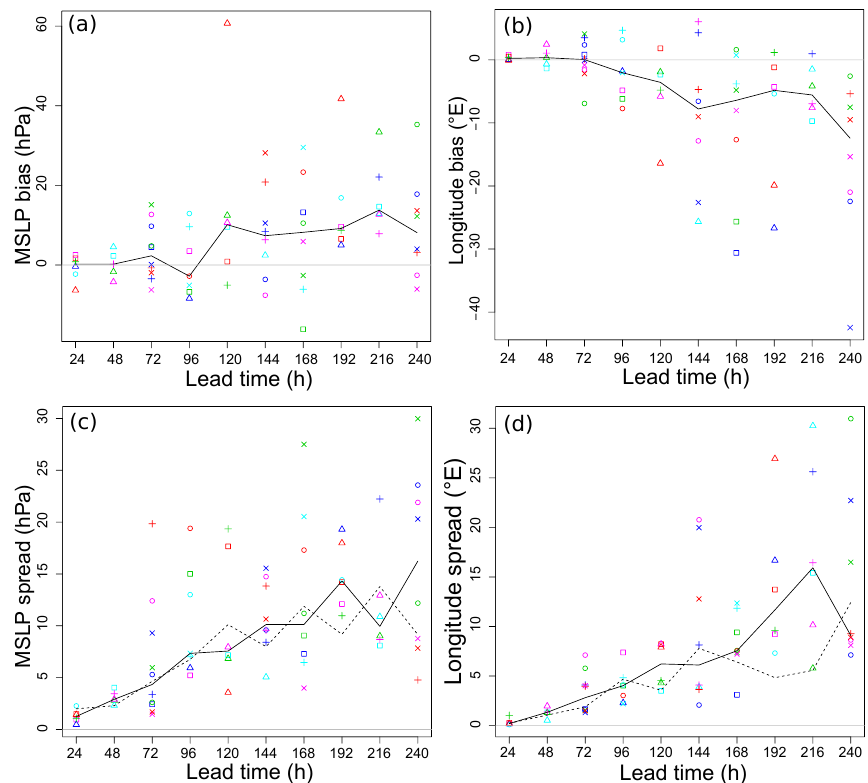
Figure 5. Position and intensity of the storms in the ensemble reforecast as identified at the time of first occurrence and compared on the day of maximum intensity: difference between the ensemble median and ERA-Interim (a, b) and median absolute deviation of the ensemble (c, d) in MSLP (a, c) and longitude (b, d) . The symbols represent the storms as given in Table 1 and the solid black curve shows the median of the storms per lead time, while the dashed black curve in (c, d) further shows the median absolute error of the storms per lead time.